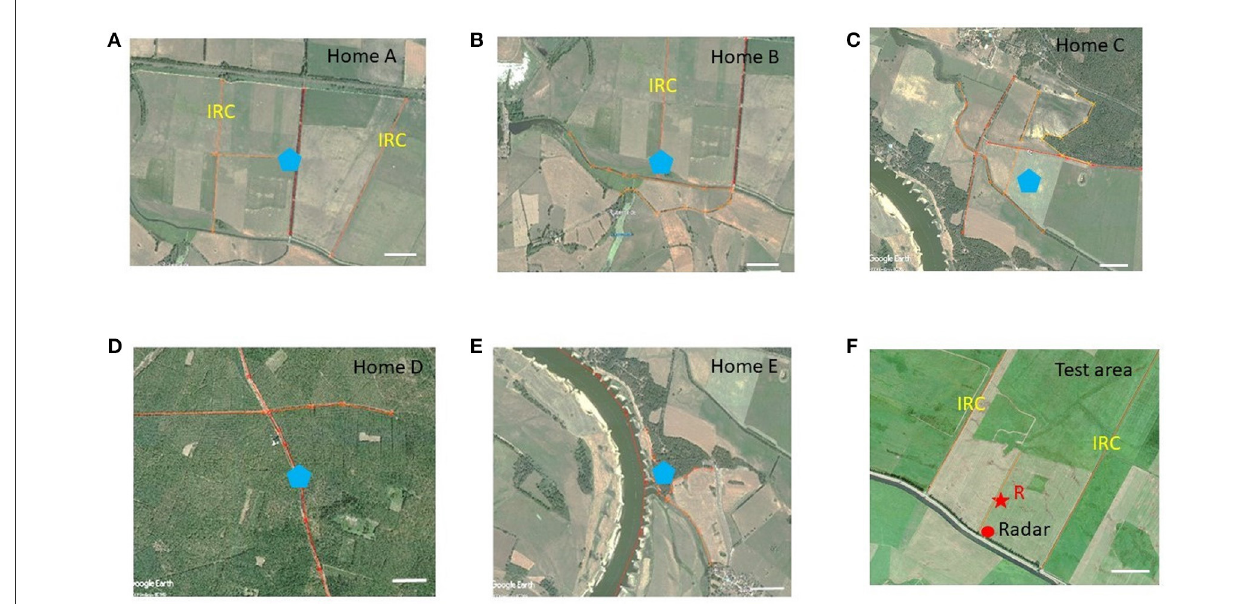
FIGURE1 Areal views of the test area (F) and the 5 home areas (A–E) . The release site R in the test area is marked with a red star, and the location of the radar with a red dot. The locations of the hives in the five home areas are marked with blue pentagons. The elongated ground structures in the test and home areas are highlighted with orange lines. The scale in each subfigure corresponds to 200m. IRC, irrigation channels. Notice that the ground structures in the test area are more similar to home areas (A, B) than to (C–E) , and that home areas (D, E) are highly different from the test area and from each other. Most importantly, the home areas differ from each other and the test area not only in the ground structures, but also in the panorama and the distribution of rising